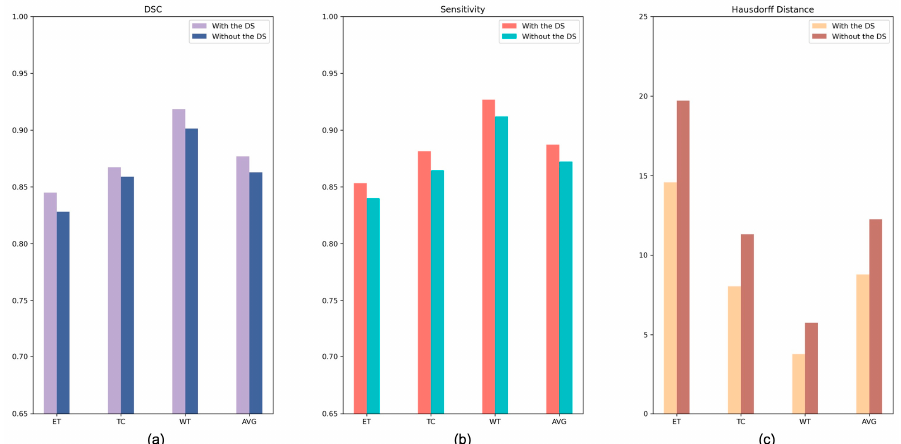
Figure 9. The performance indexes of the proposed AABTS-Net and the AABTS-Net without DS. ( a ) represents the DSC value, ( b ) represents the Sensitivity value and ( c ) represents the HD value.